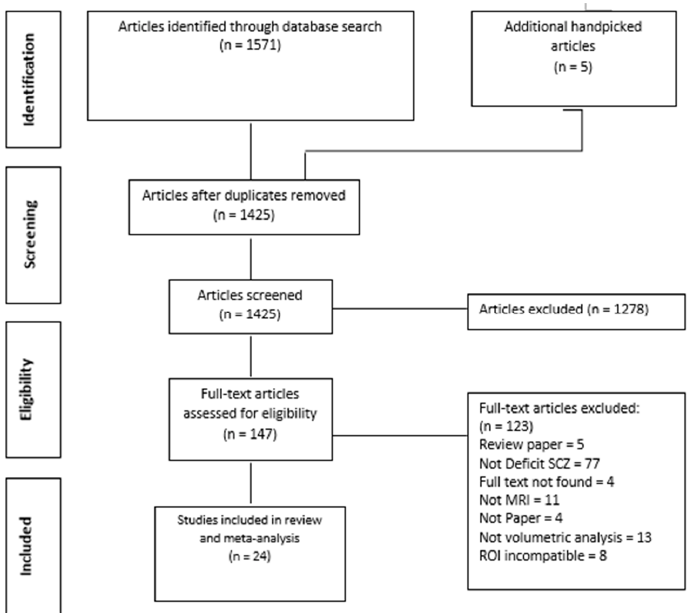
Figure 1. Process of systematic selection using the Preferred Reporting Items for Systematic Reviews and Meta-Analyses (PRISMA) flow chart.